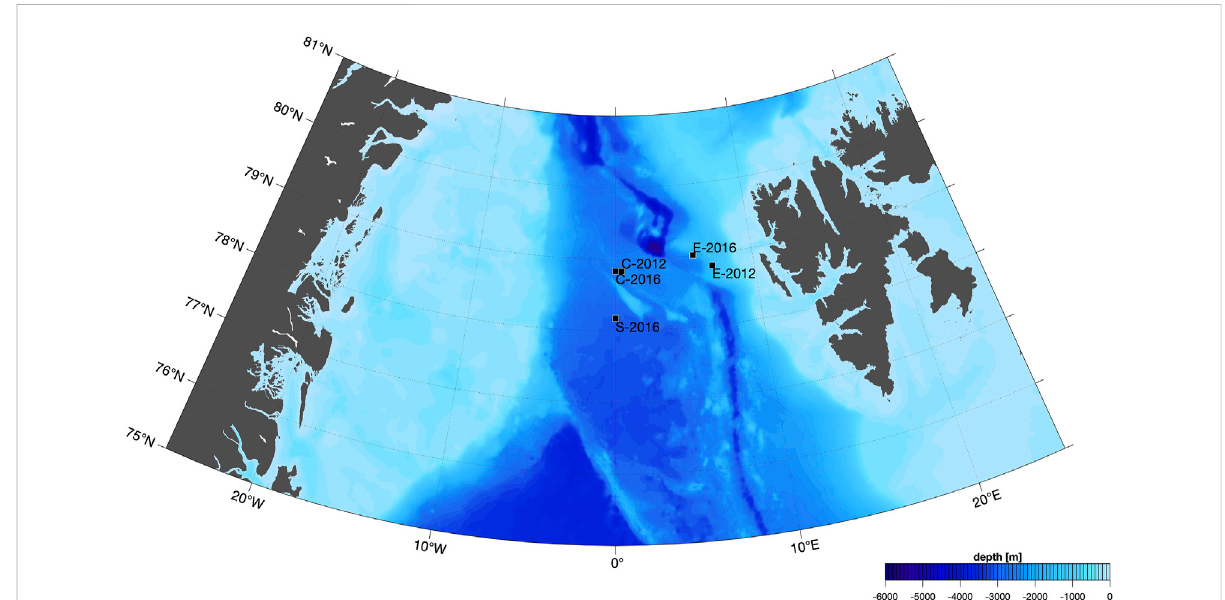
FIGURE 1 Deployment locations of the fi ve recorders in Fram Strait between Greenland and Svalbard. Recorder C-2012 and E-2012 were recording in 2012, while C-2016, S-2016 and E-2016 were recording year-round in 2016/17. C-2012 and C-2016 belong to the central recording site, S-2016 to the southern and E-2012 and E-2016 to the eastern recording